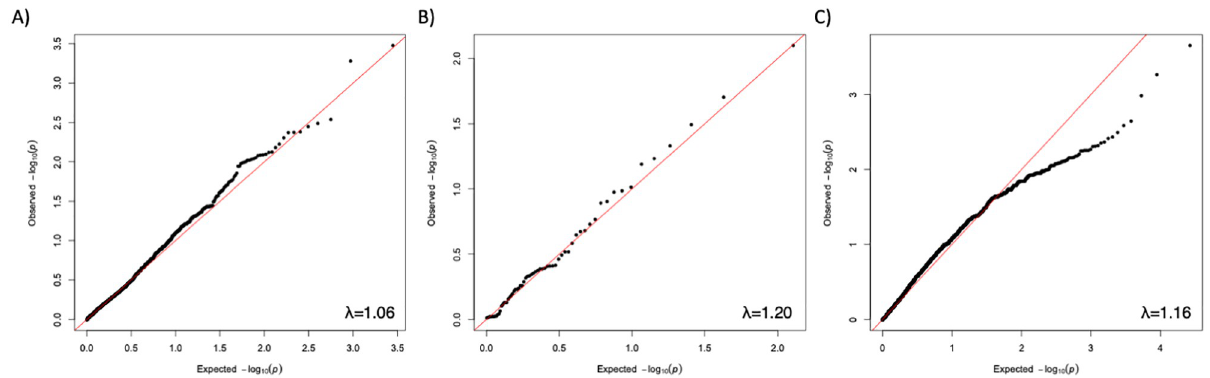
Fig 4. Quantile-quantile (QQ) plots of results from candidate SNP analysis. Plot of ACR20 significance scores from (A) 1403 SNPs previously reported to be associated with autoimmune disease, (B) 64 SNPs previously associated with rheumatoid arthritis, and (C) 13303 SNPs occurring in genes involved in TNF biological